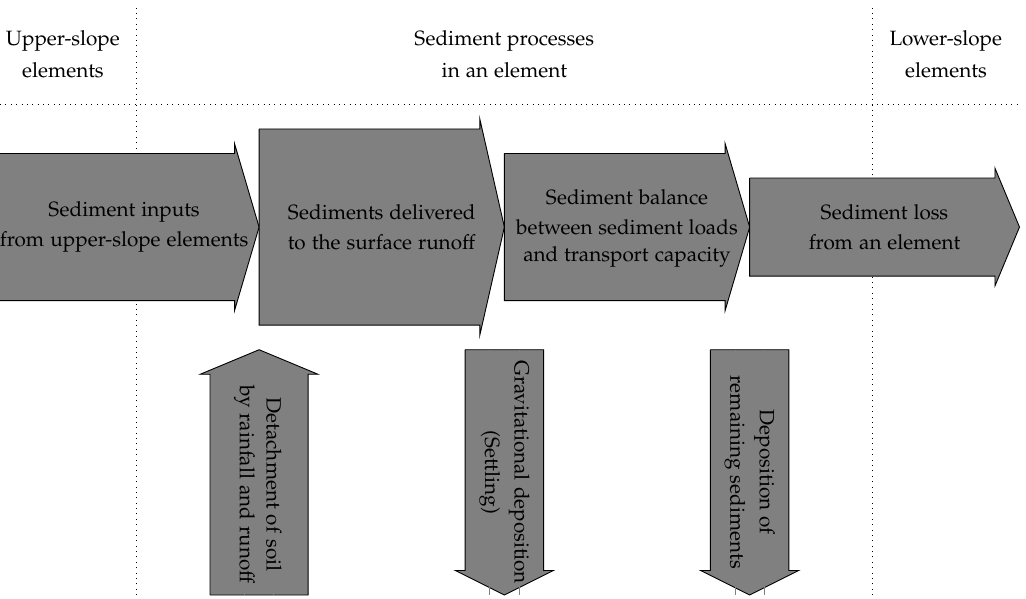
Figure 2. Schematic hydrological phase of the DMMF model (modified from Figure 3 of Choi et al. [15]).